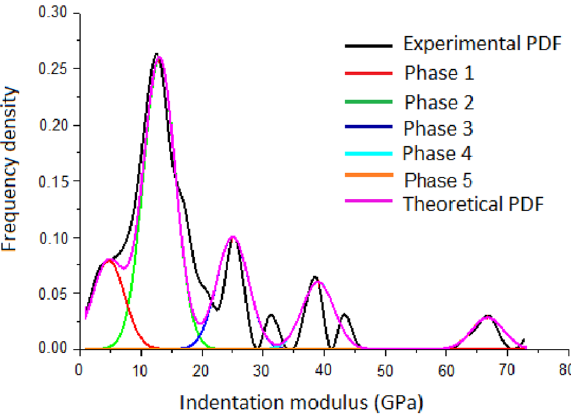
Figure 5. The frequency distribution of mortar indentation